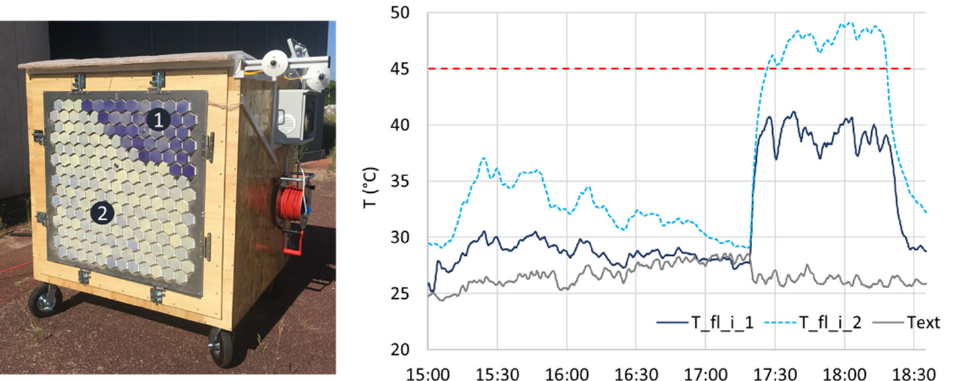
Figure 8. Photo of the test box and temperature measurements of flaps’ inner surfaces performed on the afternoon of 9 August 2021 in Bordeaux, France. Flaps are rotated differently on areas 1 (angle = 30°) and 2 (angle = 0°) and the test-box orientation is west. The red line on the graph highlights the 45 °C temperature threshold for the flaps to change their color. T ext is the external air temperature.